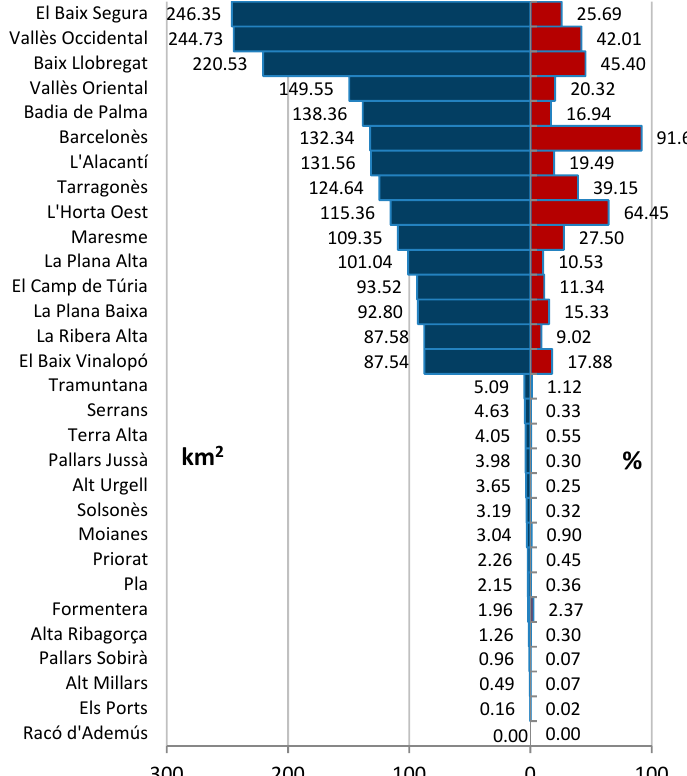
Figure 4. Absolute (km 2 ) and relative (%) values of the surface areas with levels of urban brightness per district for the mean of the months of October 2012–2017. Data for the 15 districts with the highest and lowest values of lit surface area.